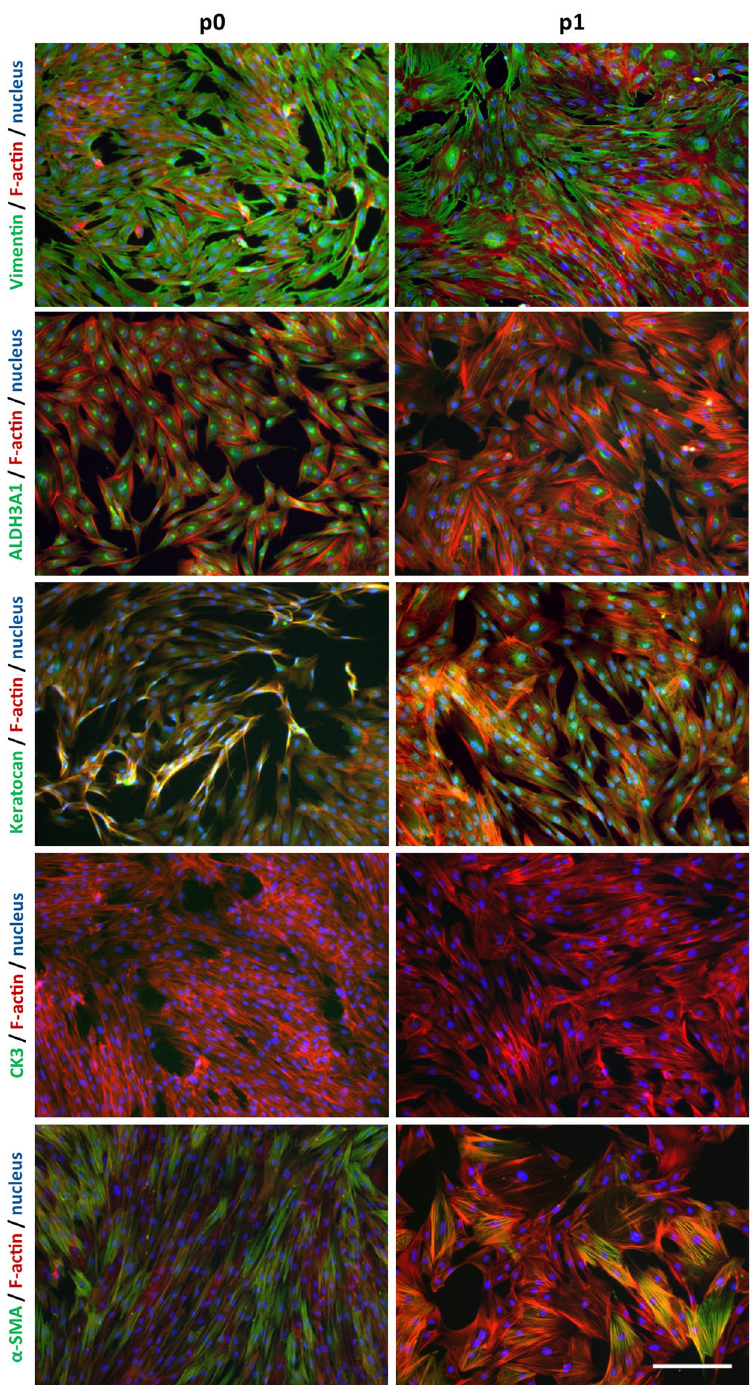
Figure 3. Phenotype of pLSCs cultured in serum-supplemented medium at passage 0 and passage 1. PLSC at passage 0 (p0) and passage 1 (p1) were stained for a variety of markers, including keratocyte markers (ALDH3A1 and keratocan), myofibroblastic markers ( α -SMA), mesenchymal stromal cells (vimentin) and epithelial cells (cytokeratin 3). Keratocyte markers showed a decreased expression after one passage, while mesenchymal markers kept constant. No epithelial contamination was observed by the lack of cytokeratin staining. Some α -SMA positive cells could be seen at both p0 and p1. Scale bar = 200 µ